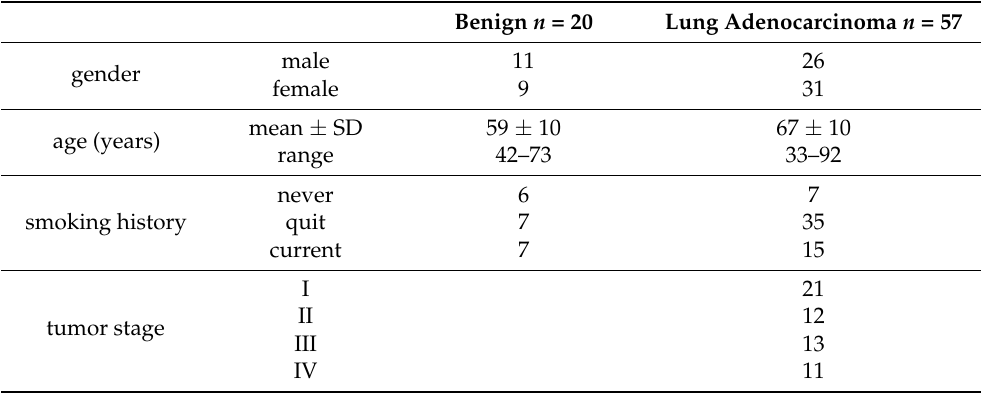
Table 1. Demograpy of patients with benign and with lung adenocarcinoma